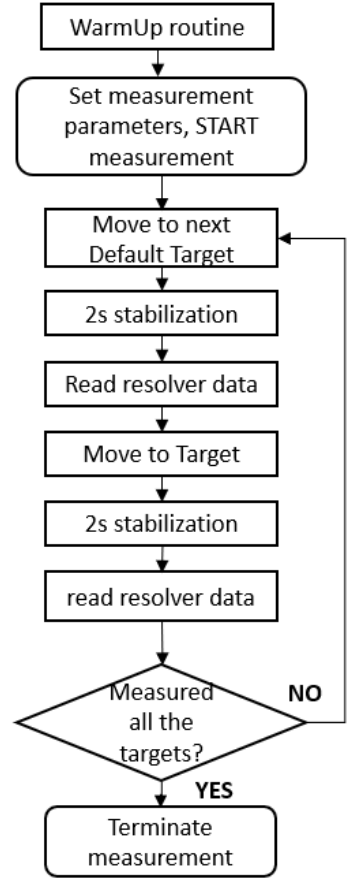
Figure 4. Experiment control system flowchart.